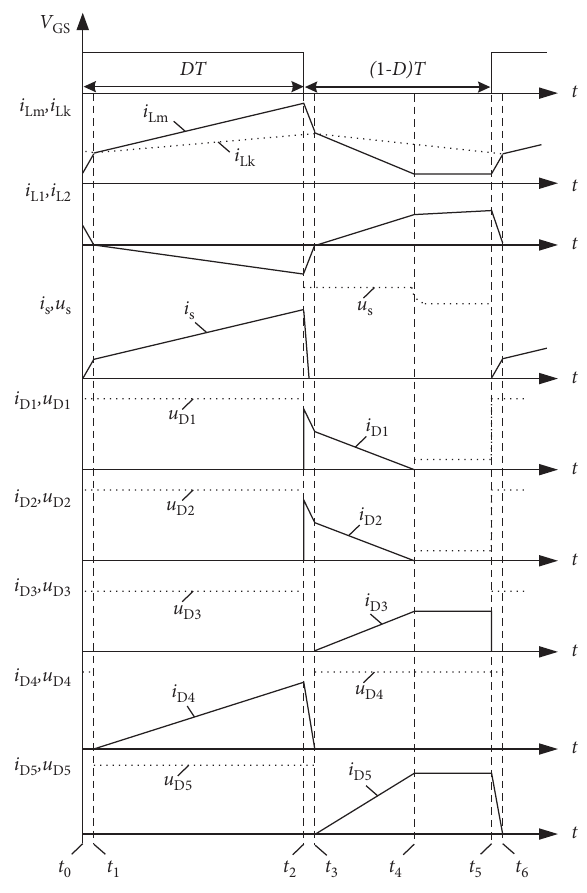
Figure 4: Converter operation